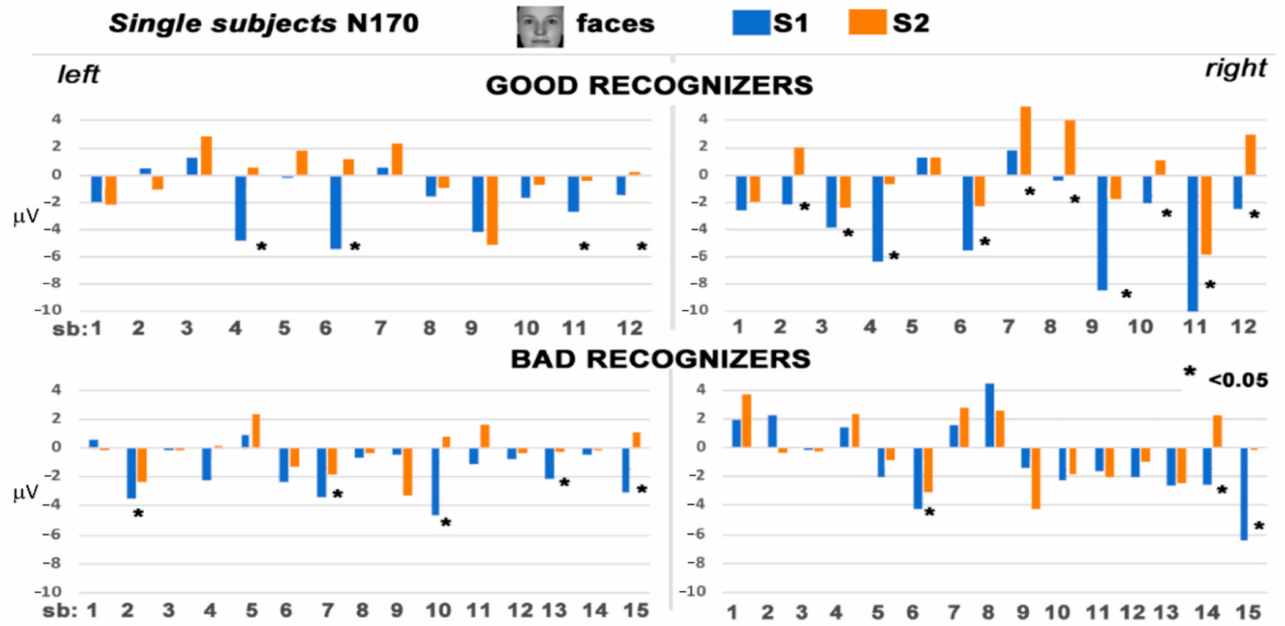
Figure 4. Single subjects (top panel good recognizers, bottom panel bad recognizers) mean amplitude values for whole faces in S1 and S2, measured in the time range of the N170 component.